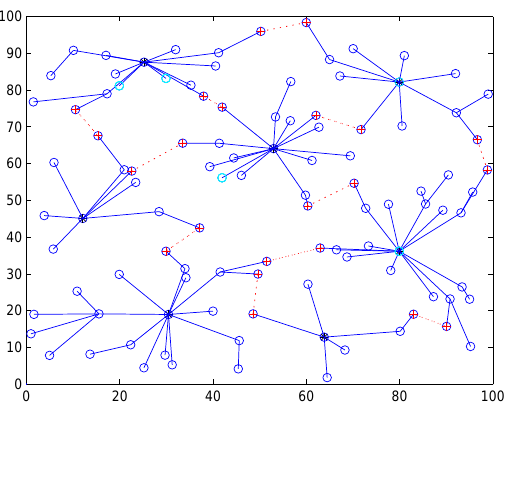
Figure 1. The influence of anti-nodes (cyan) ; the sensor network without secure topology control (left), the sensor network with secure topology control